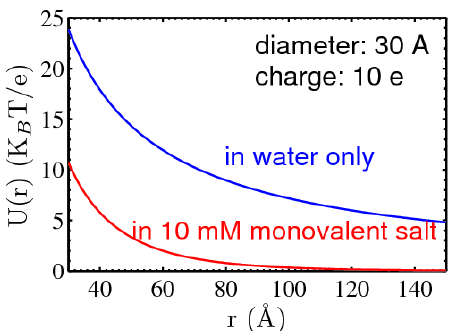
Figure 6. Visualization of Debye–Hückel potentials between two charged spheres of 3 nm diameter and 10 e bare charge. The effect of salt screening is shown for the case of 10 mM monovalent